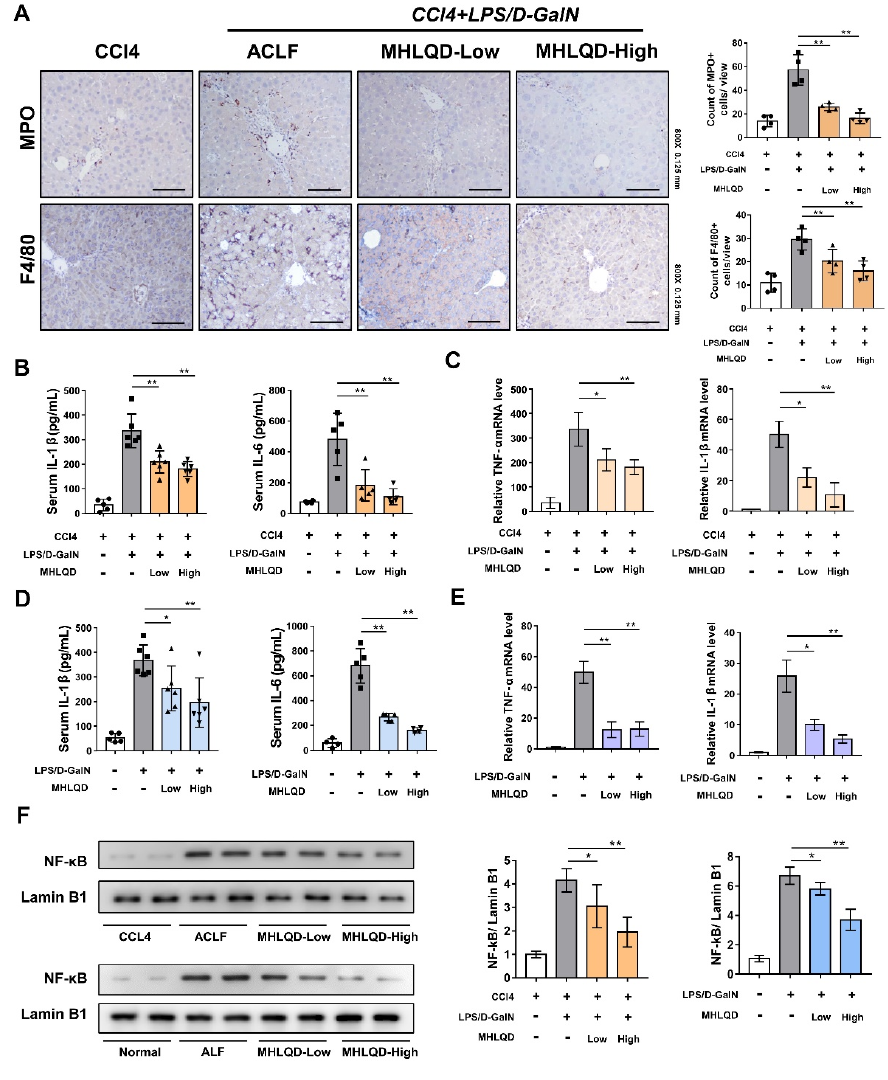
Figure 2. MHLQD alleviated liver injury and inflammatory response in ACLF and ALF mice. The mice were intraperitoneally injected with 320 mg/kg D − GalN and 30 ug/kg LPS to establish ACLF and ALF models. MHLQD (40.5 or 81 g/kg) or the same volume (0.2 mL) of PBS was orally admin- istrated to mice 1.5 h before and 1.5 h after LPS/D − GalN injection. (A): The immunohistochemical staining of MPO and F4/80 in liver tissues of ACLF mice. Scale bar: 0.125 mm. ( B ): The serum levels of IL-1 β and IL-6 in ACLF mice (n = 5). Results were shown as cytokine levels per milliliter of mice serum. ( C ): The relative mRNA expression levels of TNF- α and IL-1 β in liver tissues of ACLF mice (n = 4). ( D ): The serum levels of IL-1 β and IL-6 in ALF mice (n = 5). ( E ): The relative mRNA expres- sion levels of TNF- α and IL-1 β in liver tissues of ALF mice (n = 4). ( F ): The nucleus NF-kB expression in the liver tissues of ACLF and ALF mice. * p < 0.05, ** p < 0.01. Abbreviation: MHLQD: MaHuang- LianQiao-ChiXiaoDou decoction, ACLF: acute-on-chronic liver failure, ALF: acute hepatic failure. 3.5. MHLQD Reduced Hepatocyte Death in ACLF and ALF Mice TUNEL staining showed that TUNEL-positive hepatocytes in the ACLF/ALF group were higher than those in the CCl 4 /Normal group, respectively . MHLQD treatment sig- nificantly reduced the TUNEL-positive hepatocytes (Figure 3A,C). We further examined the expression of P-MLKL, which has been used as a necroptosis marker. The staining